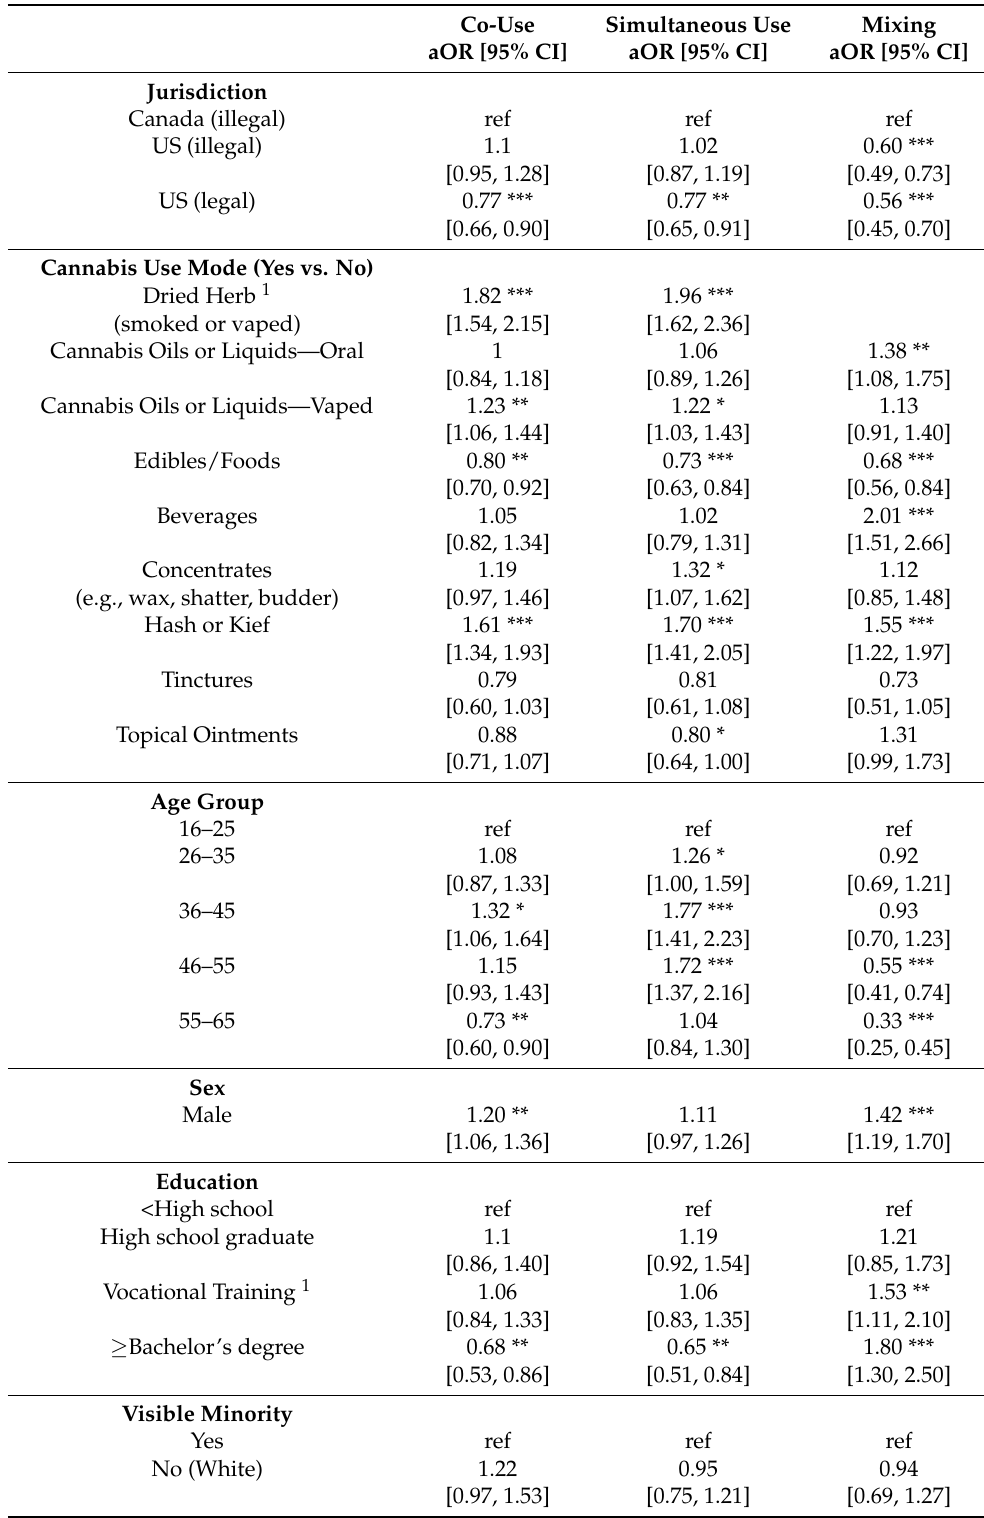
Table 3. Modes of use as independent predictors of co-use, simultaneous use, and mixing among past-year cannabis consumers in Canada and the United States (n =